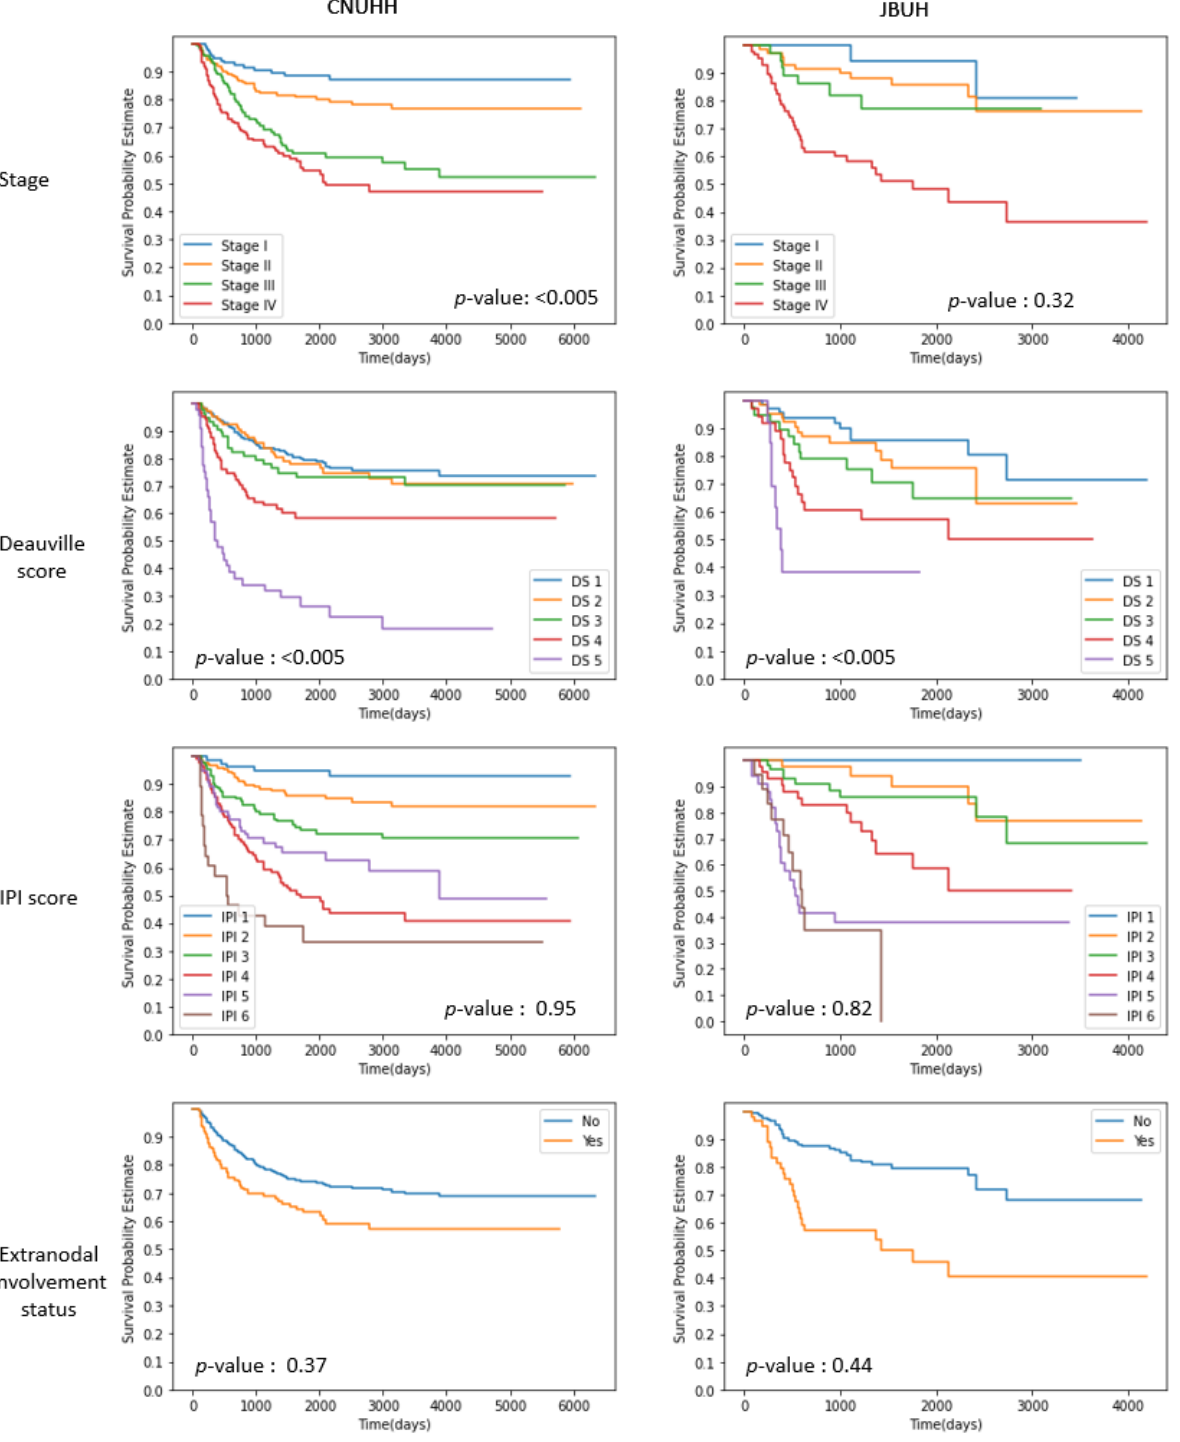
Figure 2. Kaplan–Meier plots of overall survival according to the stage, the Deauville score, the international prognostic index (IPI) score, and extranodal involvement status in the CNUHH and JBUH datasets.